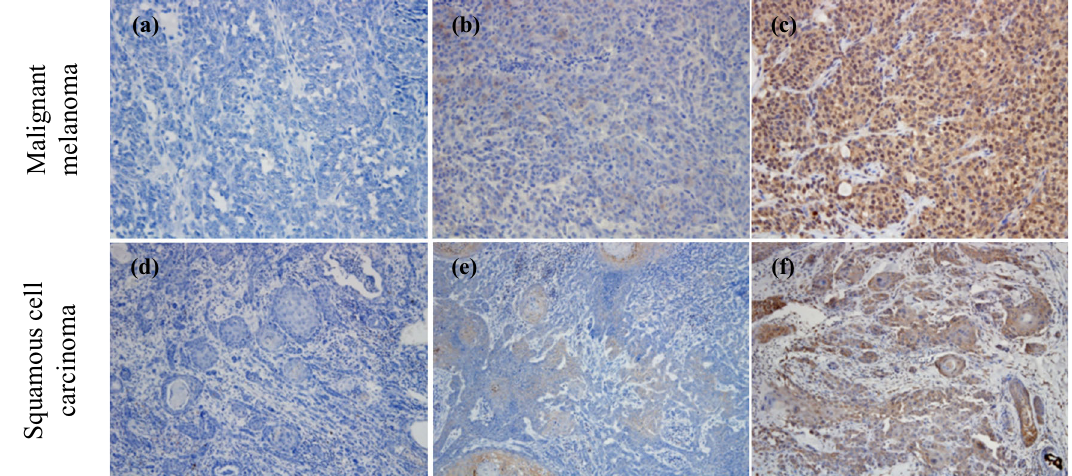
Fig. 1 Representative PD-L1 immunohistochemistry results with 6C11-3A11 for each tumor proportion score (TPS). The proportion of PD- L1 – expressing tumor cells was scored according to the percent of stained viable tumor cells (see “ Methods ” ). Representative IHC results for TPS < 1% ( a , d ), 1 – 49% ( b , e ), and ≥ 50% ( c , f ) are shown. Original magni fi cation, ×200 ( a – c ) or ×100 ( d – f